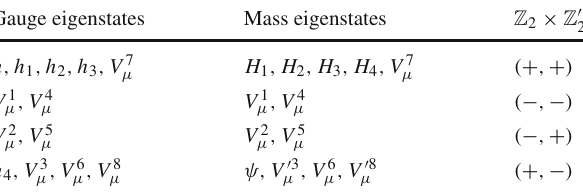
Table 2 Natural parameter choices for different multi-component dark matter scenarios